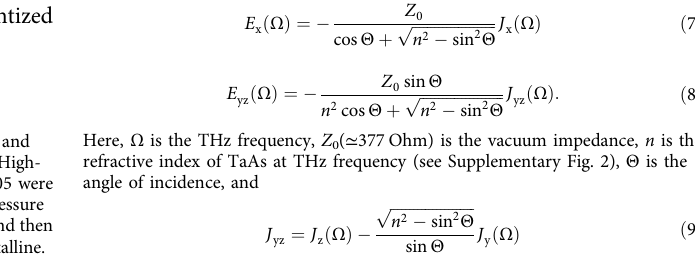
ð ω Þ and J ð ω Þ , as a function of the photon energy originating from the LPGE and photo- x yz